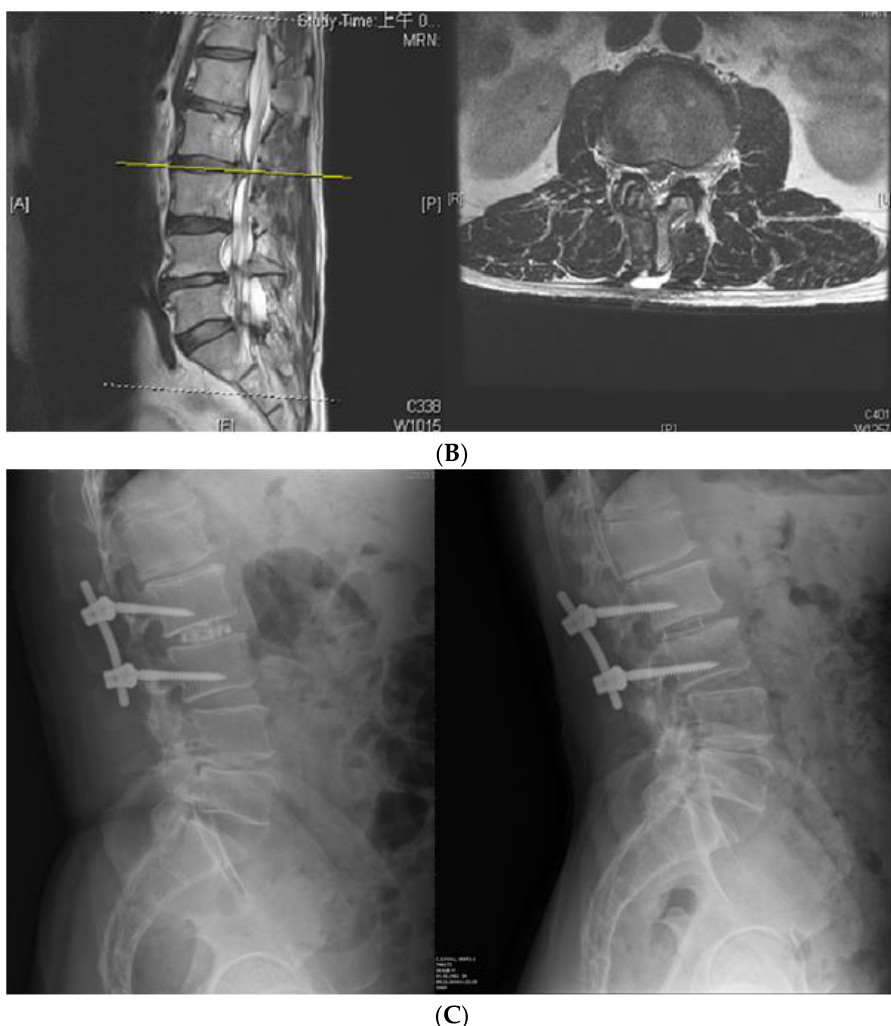
Figure 1. A 51-year-old male patient suffered from right radiculopathy due to a L2-3 herniated intervertebral disc (HIVD), on the right side ( A ), and received decompression surgery. The symptoms were relieved after operation. However, four months later, the symptoms developed again, and magnetic resonance imaging (MRI) showed recurrence of HIVD at L2-3 ( B ). Revision surgery was then performed with instrumentation plus cage ( C , right). During follow-up for 4 years, the radiography showed stable implants ( C , left).